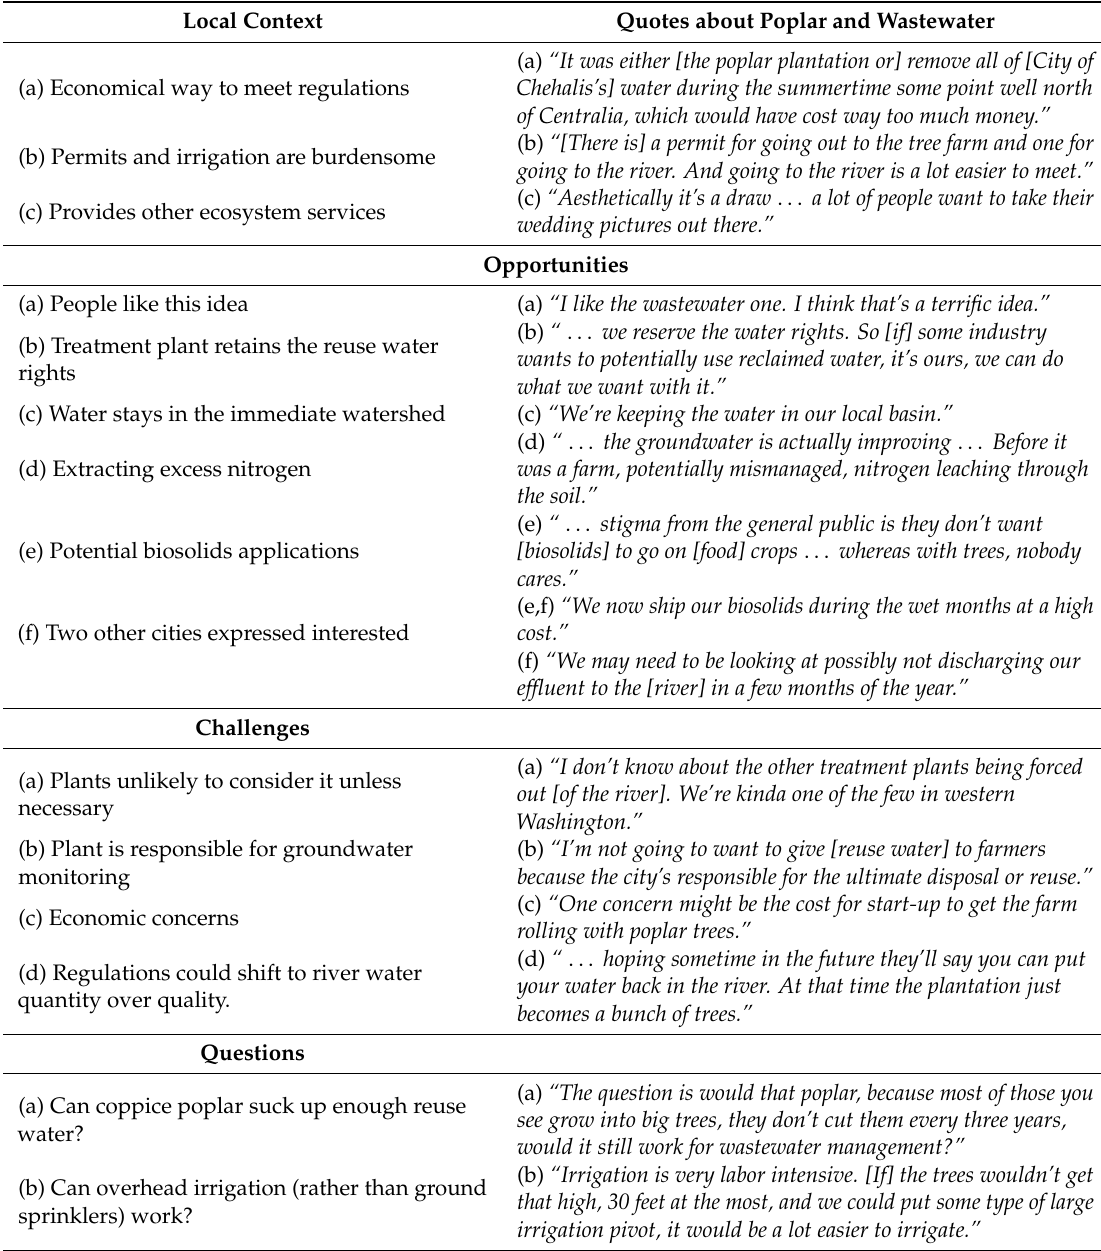
Table 4. Summary and quotes related to the potential for poplar to provide ecosystem services for wastewater management in southwestern Washington, from participant stakeholders in agriculture and natural